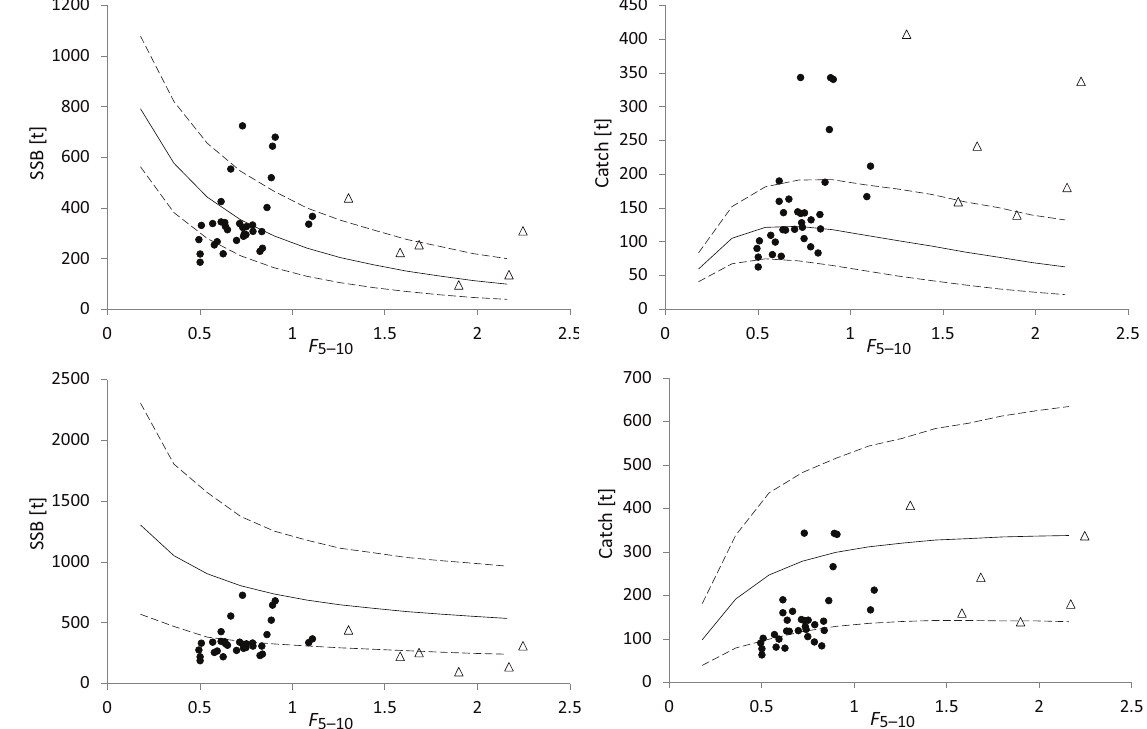
Fig. 4. Selected population characteristics of the Pärnu Bay pikepearch ( Sander lucioperca ): Spawning stock biomass (left) and catch (right) in equilibrium with different levels of fishing mortality, assuming low (top) or high (bot- tom) food supply expressed as goby abundance; Lines show average simulated SSB and catch (continuous), with 5% and 95% percentiles (dashed). Markers denote observed SSB and catches (Eero 2004) with no (circles) and significant (triangles) catch of immature fish; F 5–10 = average fishing mortality age